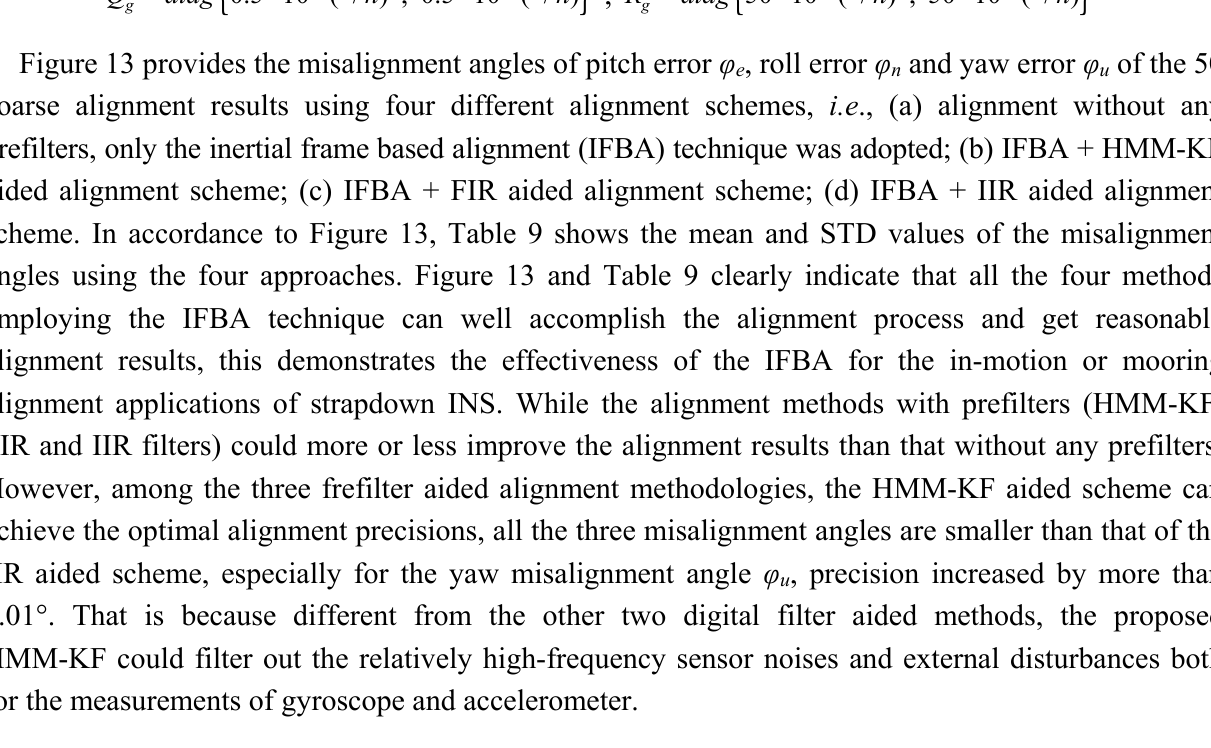
Figure 13. 50 times turntable coarse alignment experiments results. ( a )